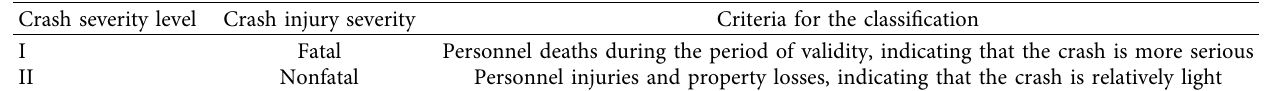
Table 5: Classification of crash injury severity in urban-rural fringes.